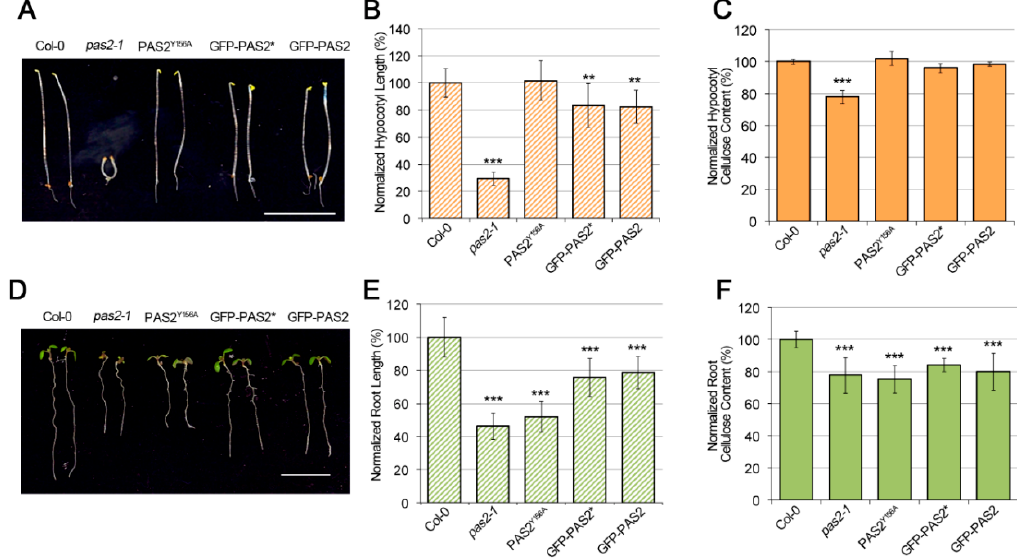
Figure 2. Phenotypic comparisons and cellulose content among wild-type (Col-0), pas2-1 , GFP-PAS2 Y156A , GFP-PAS2 and GFP-PAS2* seedlings. ( A ) Images of 4-day-old dark-grown seedlings. Bar = 1 cm. ( B ) Quantification of the length of 4-day-old etiolated hypocotyls. ** p < 0.001, *** p < 0.0001 (n ≈ 50 per transgenic line). Error bars represent SD. ( C ) Cellulose content of 4-day-old dark-grown seedlings. *** p < 0.0001. Error bars represent SD. ( D ) Images of 7-day-old light-grown seedlings. Bar = 1 cm. ( E ) Quantification of the root length. *** p < 0.0001 (n ≈ 50 per transgenic line). Error bars represent SD. ( F ) Cellulose content of 15-day-old dark-grown seedling roots. *** p < 0.0001. Error bars represent SD.